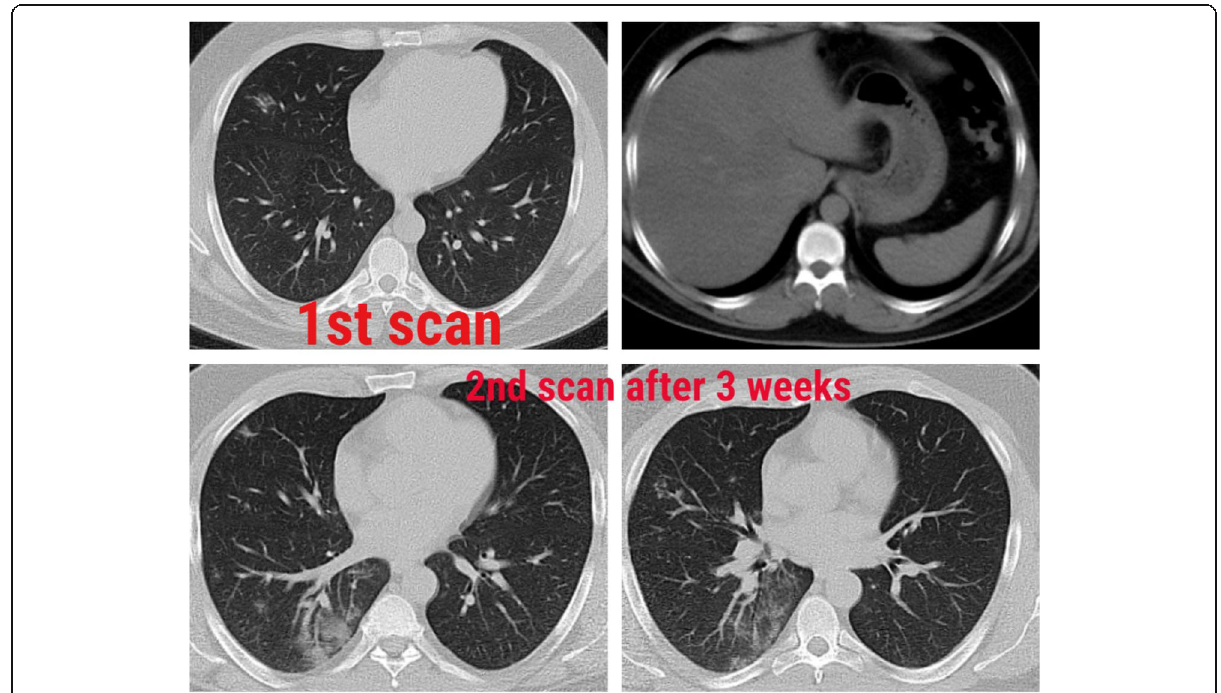
Fig. 3 Male patient, 36 years old. The first scan after few days of symptoms shows just a small patchy ground-glass opacity in the middle lobe. The second scan after 3 weeks for follow-up shows a progressive course with multiple pulmonary ground-glass opacities. CT cuts of the upper